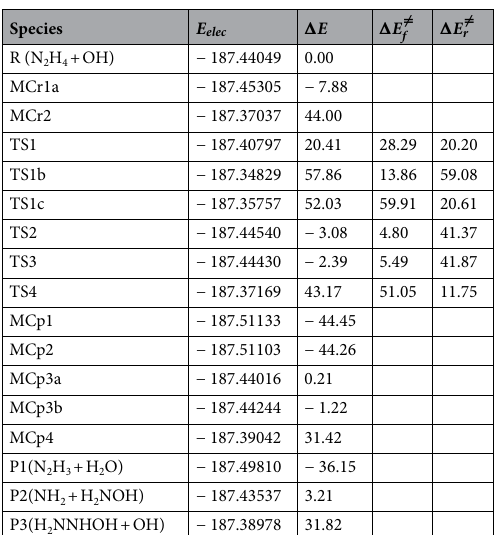
Table 2. The electronic energies (in Hartree), relative energies ( (cid:31) E ) (in kcal mol −1 ), forward barriers heights = −1 ), and reverse barrier heights ( (cid:31) E = r ) (in kcal mol −1 ) of the reliable paths of N ( (cid:31) E f ) (in kcal mol reactions at the CCSD(T)/CBS